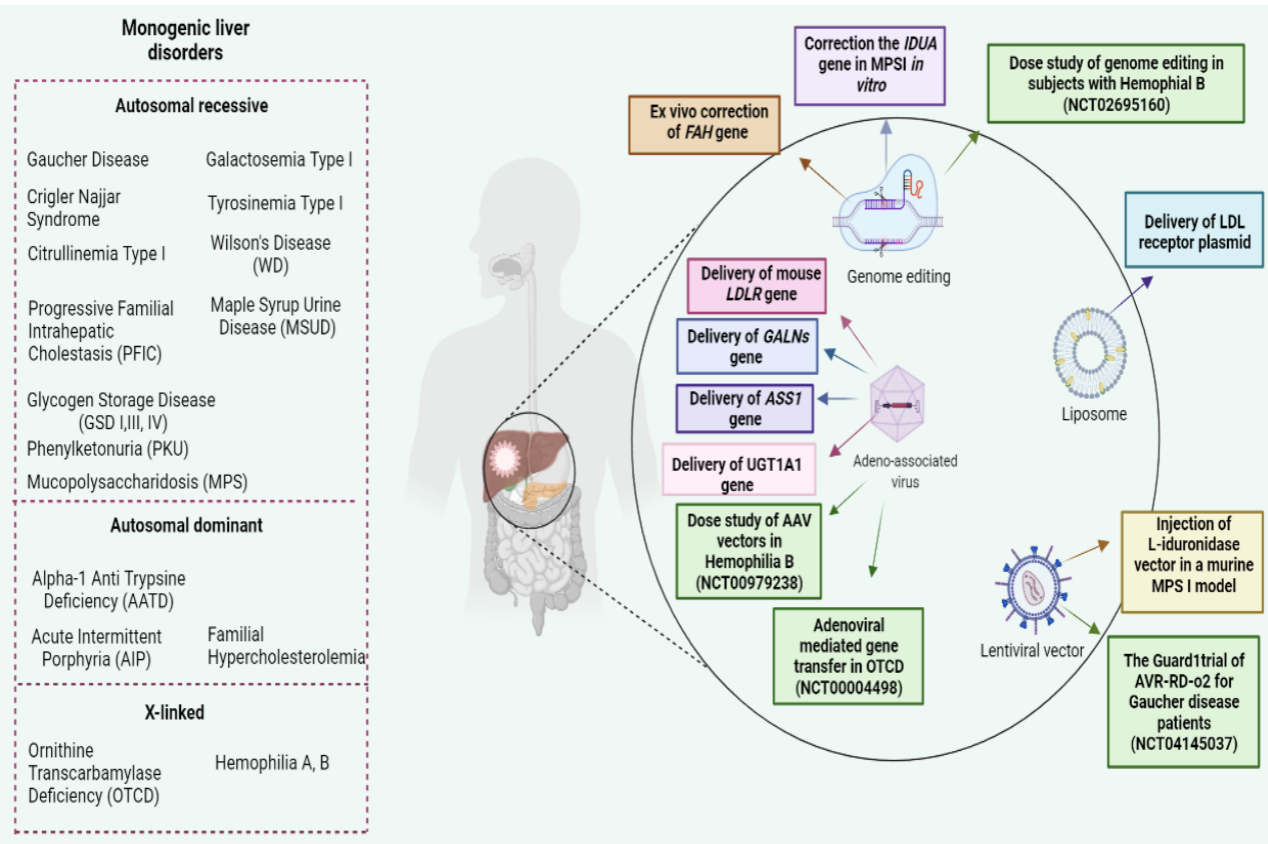
Figure 1. Common monogenic liver disorders and proposed gene therapy approaches. The figure was created with Biorender (www.biorender.com (accessed on 21 June 2022)). Viral vectors are important gene-transferring mediators. They are potentially admin-